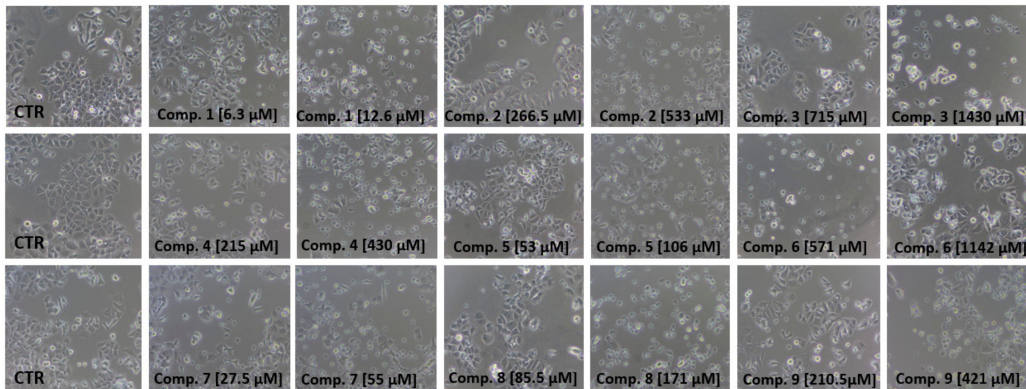
Figure 5. Dose-dependent e ff ects of sulfonamide derivatives of metformin (compounds 1 – 9 ) at concentrations corresponding to their 1 viability and morphology after 24 h of incubation. Representative cell images are shown (100-fold magnification);